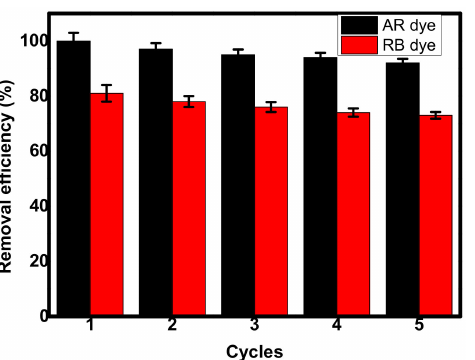
Figure 6. Reusability of Fe 3 O 4 -NH 2 @MIL-101(Cr) laccase for AR and RB dye removal for up to five